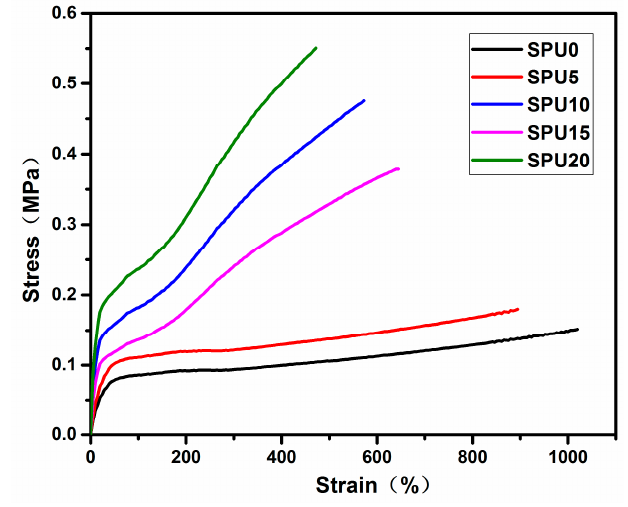
Figure 14. Tensile stress–strain curves of SPU with different HDI-T contents.